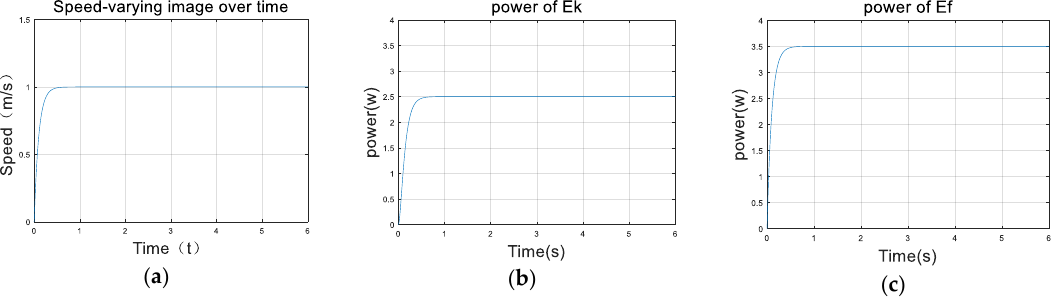
Figure 2. Speed, Ek , and Ef change versus time. ( a ) Speed change versus time; ( b ) Kinetic energy Figure 2. Speed, 𝐸𝑘 , and 𝐸𝑓 change versus time. ( a ) Speed change versus time; ( b ) Kinetic energy changes; ( c ) Friction changes; ( c ) Friction dissipation.